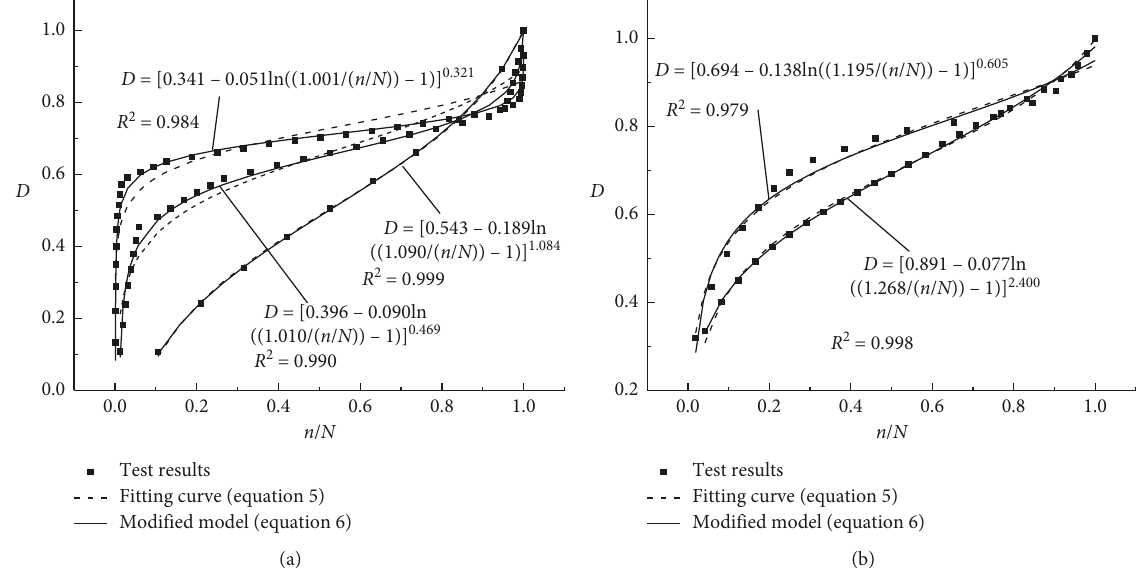
Figure 10: Damage variable fitting curve based on damage model. (a) Cyclic loading test and (b) cyclic creep test. Table 3: Fitting results of parameters α , β , c, and m . Maximum stress No.